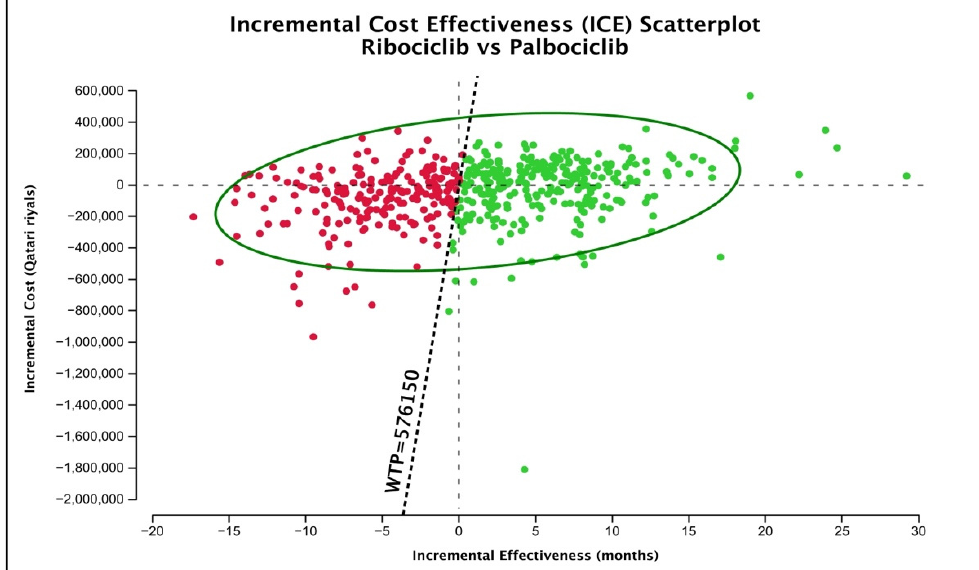
Figure 3. ICE plot of ribociclib versus palbociclib. Green dots represent the scenarios favoring ribociclib over palbociclib at a 3 GDP WTP of QAR 576,150.